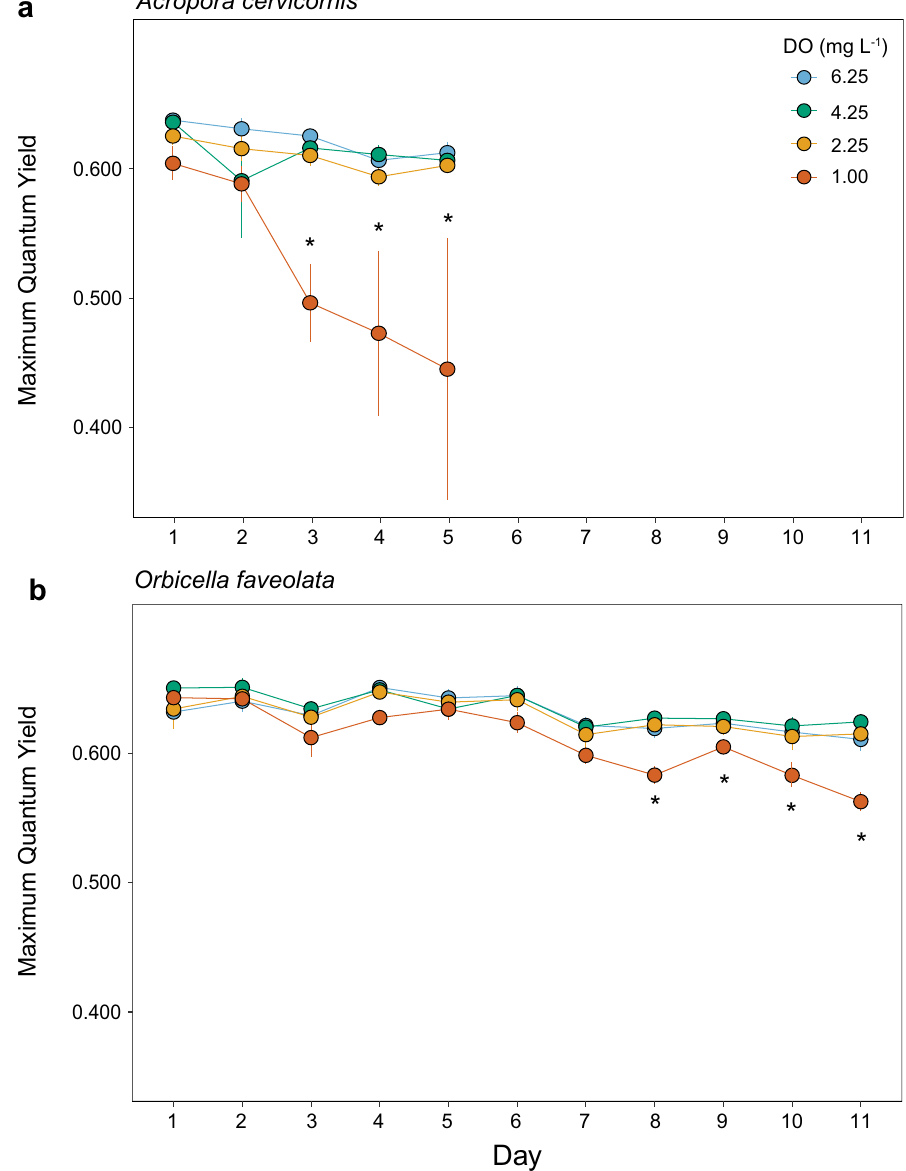
Figure 3. Maximum quantum yield under deoxygenation. ( a ) Mean ± SE quantum yield for Acropora cervicornis and ( b ) Orbicella faveolata for the duration each experiment (n = 3). Corals were measured prior to dawn for maximum quantum yield (F v /F m ). Asterisks indicate significant differences ( P < 0.05) between the 1.00 mg L −1 treatment and all other treatments on a given